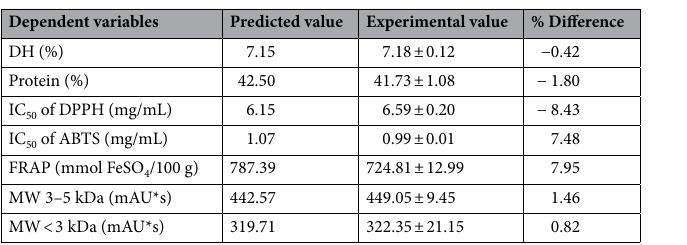
Table 4. Experimental data of the validation at optimal extraction